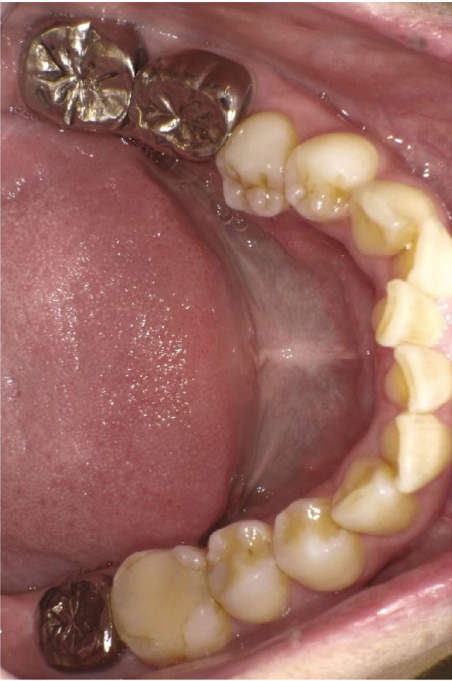
Figure 8: Twenty-eight years after the transplantation. Probing depth was less than 3mm and gingival health was con fi rmed. There is no alveolar bone loss that was noted around the transplanted tooth. A radiolucency was noted in the pulp chamber which reached to the furcation area. However, no clinical pathological changes were noted.